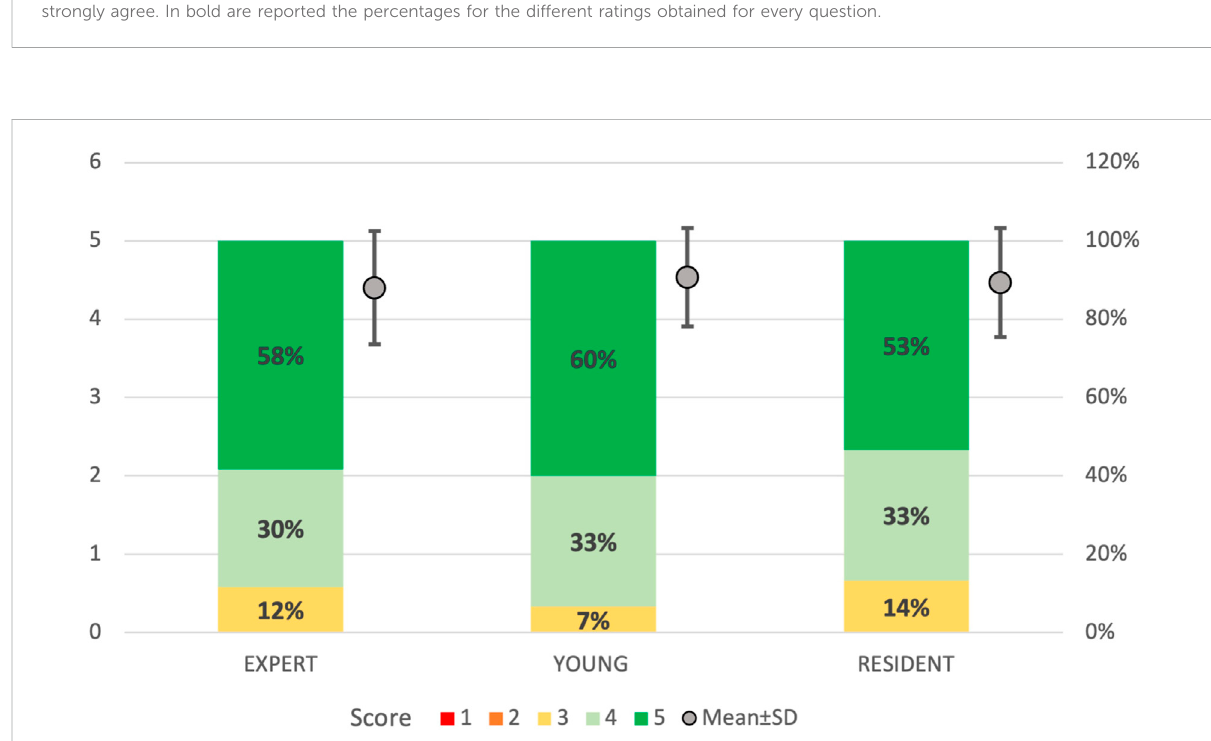
FIGURE 11 5-point Likert scale ratings divided by groups of participants. “ Resident ” : ENT residents from the third and fourth year; “ Young ” : ENT specialists with less than 3 years of practice; “ Expert ” : experienced ENT surgeons with more than 10 years of practice. 1: strongly disagree; 2: disagree; 3: neutral;4:agree;5:stronglyagree.Inboldarereportedthepercentagesforeachratinggivenbythedifferentmembersofthegroups.Ingraydotsare reported the mean and standard deviation of the scores obtained for every